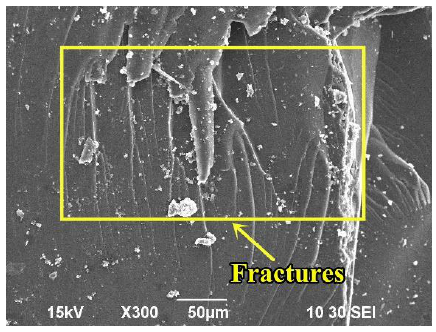
Figure 1. Micromorphology of coal sample. Table 1. Industrial analysis and basic parameters of coal sample.